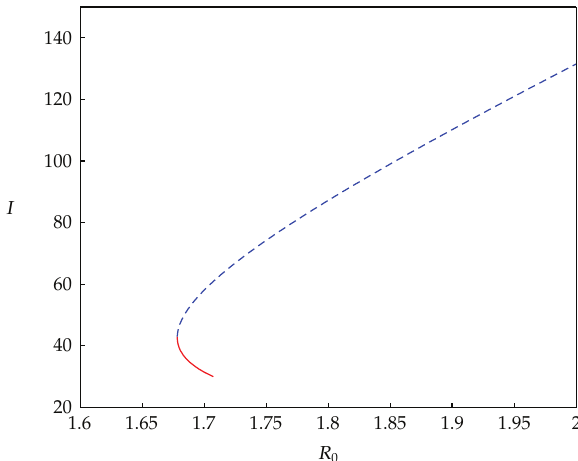
Figure 1: The figure of infective sizes at equilibria versus R 0 when I 0 (cid:7) 30, A (cid:7) 80, β 1 (cid:7) 0 . 01, β 2 (cid:7) 0 . 01, (cid:7) 1 . 6782, p (cid:7) 1 . 541, p (cid:7) 1 . 7074, where (cid:5) i (cid:6) of Theorem 2.2 holds. γ (cid:7) 0 . 01, d (cid:7) 0 . 9, (cid:4) (cid:7) 0 . 01, r (cid:7) 1, p 0 1 2 The bifurcation from the disease-free equilibrium at R 0 (cid:7) 1 is forward, and there is a backward bifurcation from an endemic equilibrium at R 0 (cid:7) 1, which leads to the existence of multiple endemic